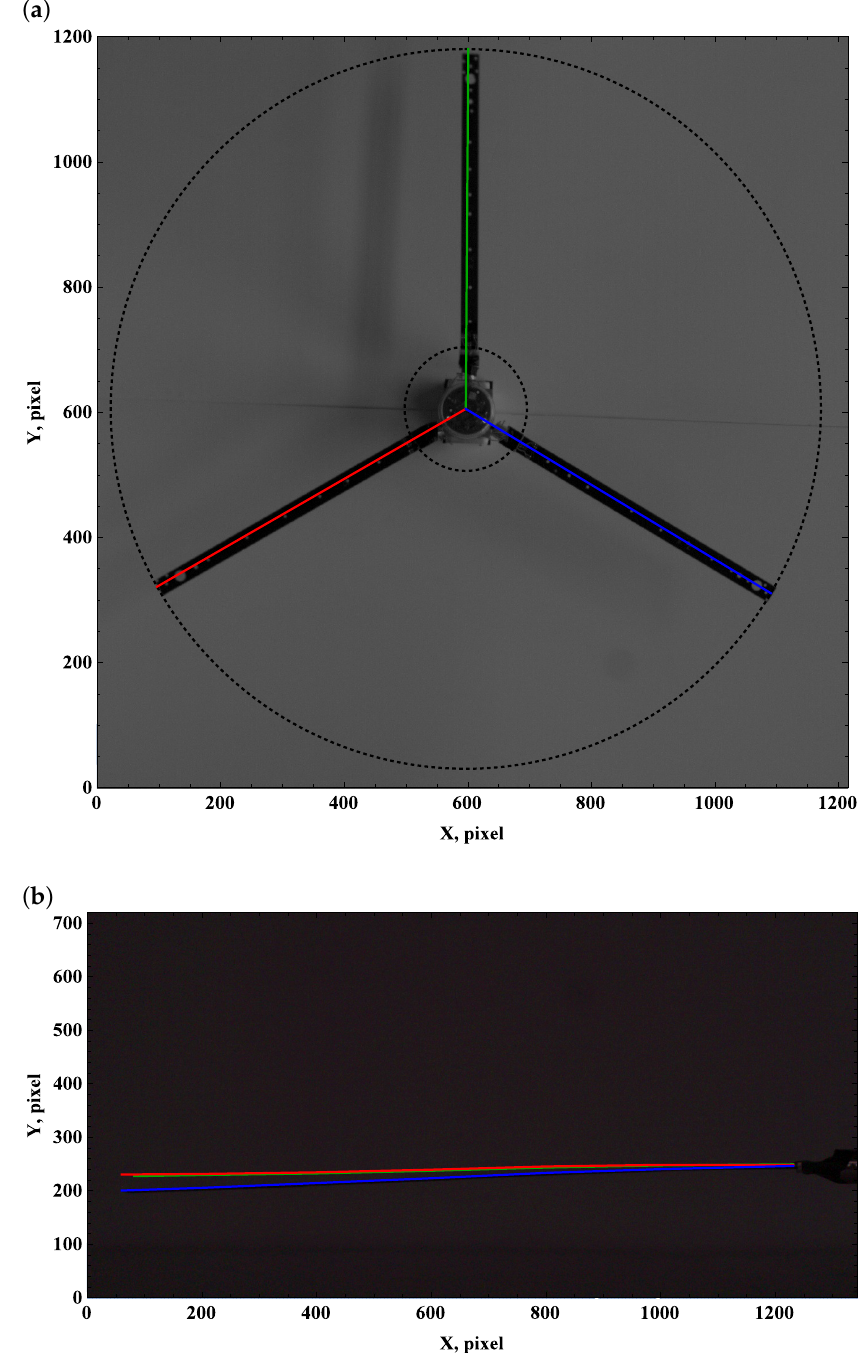
Figure 6. Preset angle 5 ◦ , angular speed 50 rpm: top view ( a ), side view ( b